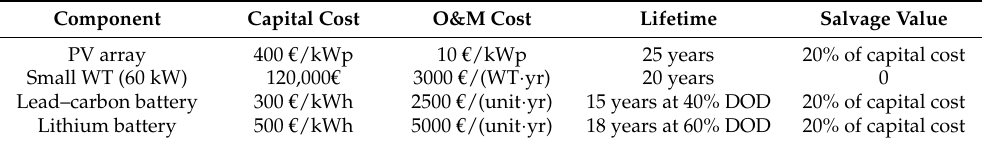
Table 1. Characteristics of the HMU campus microgrid components.